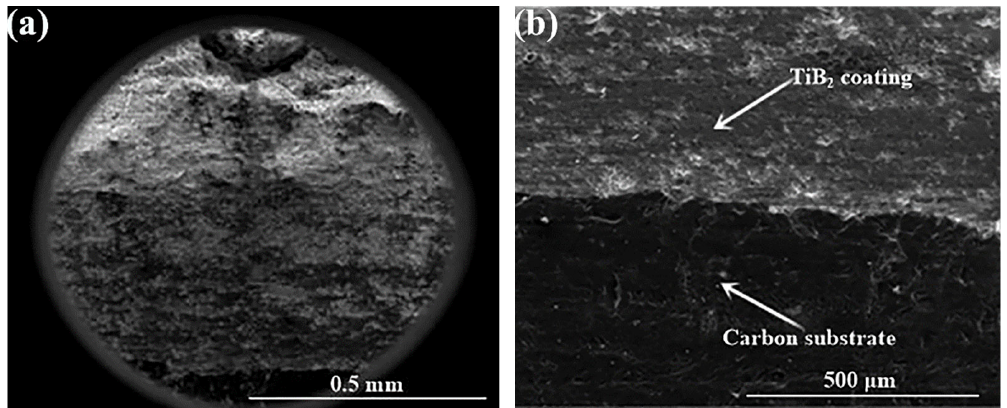
Figure 10. The section after the corrosion of the TiB 2 coating.( a ) Low-magnification figure and ( b ) Micro-topography.